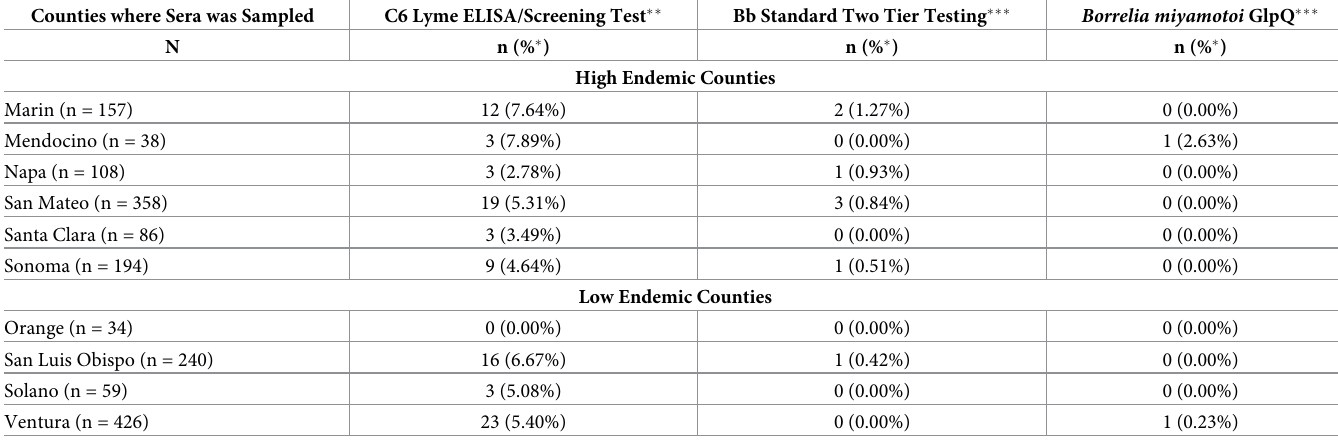
positive and 16 equivocal) of the 759 samples from low endemic counties. Ninety-one samples that were C6 ELISA positive/equivocal and nine randomly selected neg- ative samples had additional testing. A little more than half (58%) of the 91 samples that were positive or equivocal were from male individuals. The mean age for males was 42.6 years (range 16 years to 80 years) while the mean age of females was 49.6 years (range 16 years to 77 years). Most individuals with positive or equivocal samples were non-Hispanic (87%). Ethnicity (high endemic: Non-Hispanic (93.9%); low endemic: Non-Hispanic (78.6%); P-value = 0.058), sex (high endemic: male 55.1%; low endemic: male 61.9%; P-value = 0.5) and age (high endemic: Table 2. Testing results of sera samples for B . burgdorferi and B . miyamotoi by county. Counties where Sera was